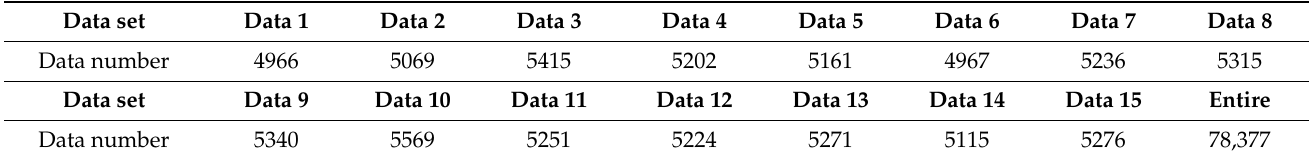
Table 3. Multiclass instance data